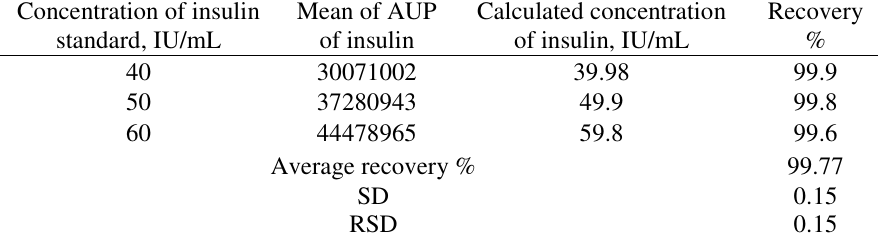
Table 2. Specificity results in presence of vial